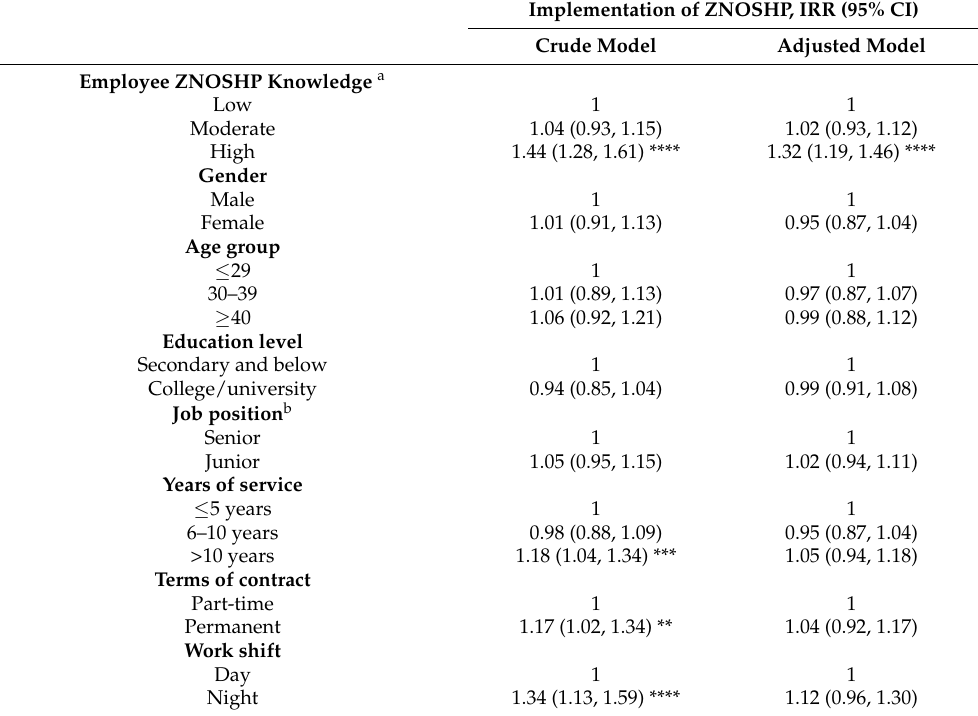
Table 3. Negative binomial regression of the implementation of the ZNOHSP in Willowvale industrial area, Harare, n =